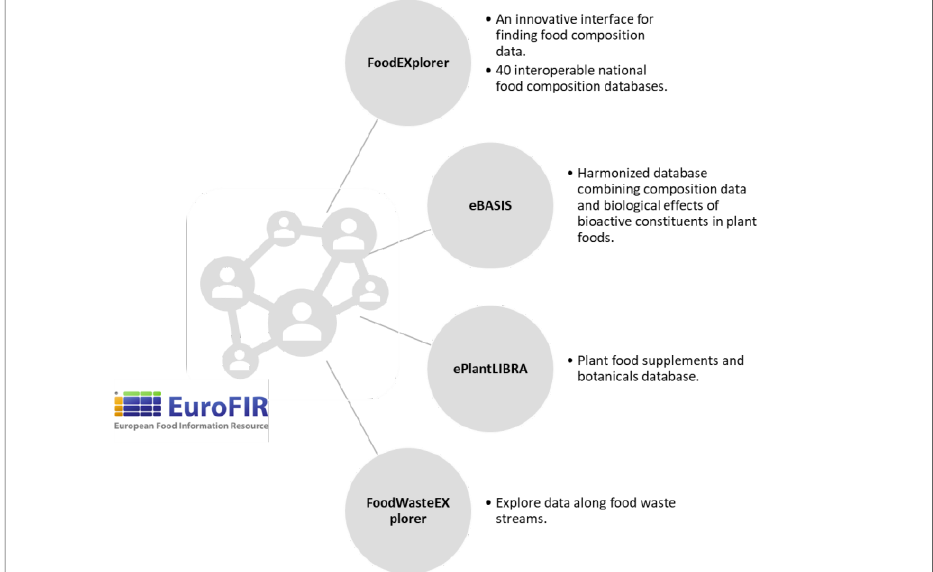
Figure 2. Representation of main EuroFIR AISBL tools.